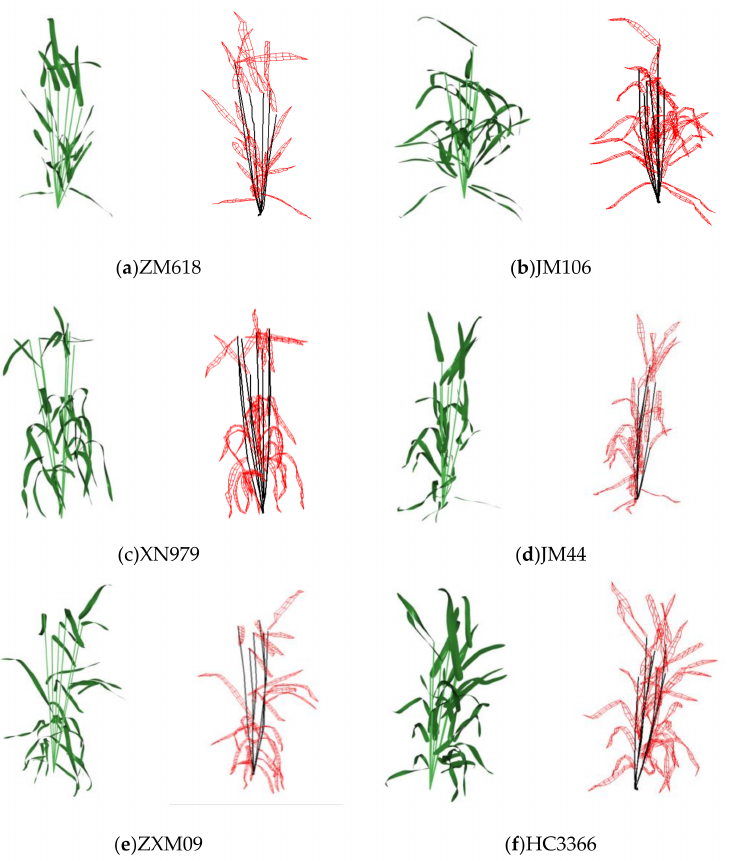
Figure 10. Comparison between modelling results and 3D digitizing data of six wheat cultivars. ( a )–( f ) are the modeling and comparison results of ZM618, JM106, XN979, JM44, ZXM09, and HC3366, respectively.